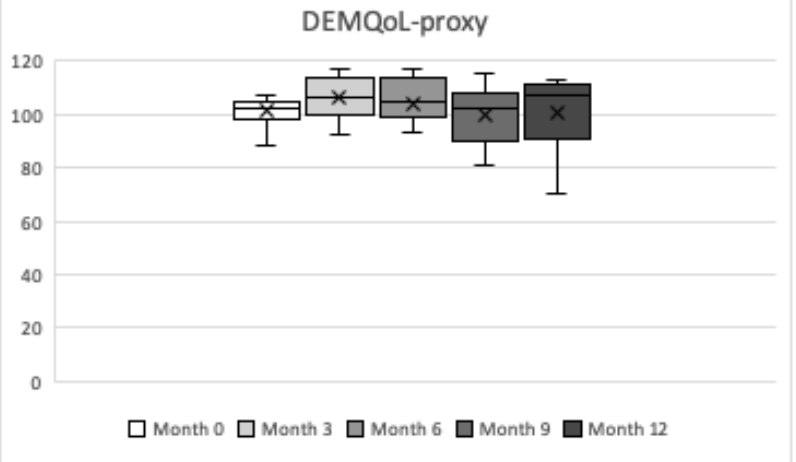
Figure 4. People with dementia informal caregiver reported Quality of Life during the year observation period (minimum, quartile 1, median, quartile 3,